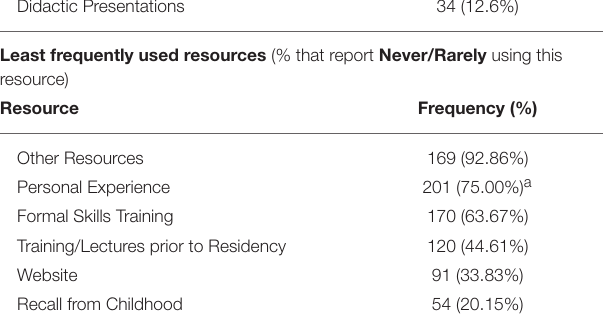
Covariate Estimate p -value